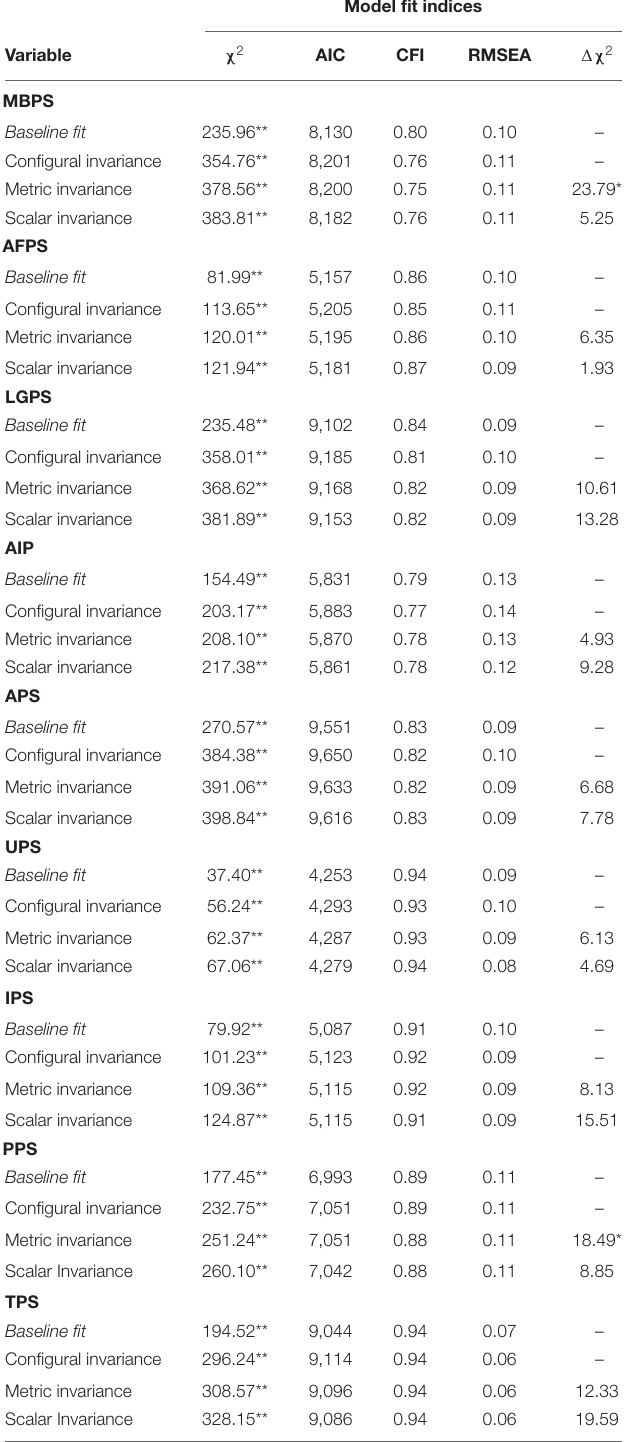
TABLE 4 | Correlations between individual survey instruments and continuous behavioral measures.